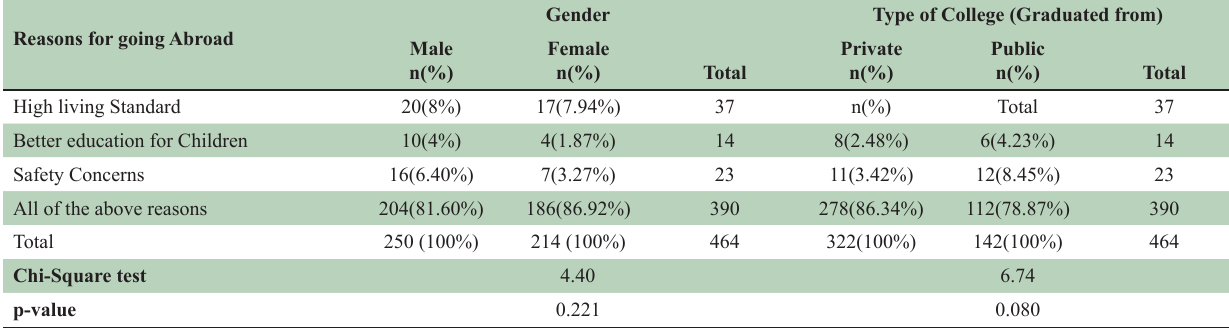
Table-III: Reasons for going Abroad with Gender and Type of college (graduated from).